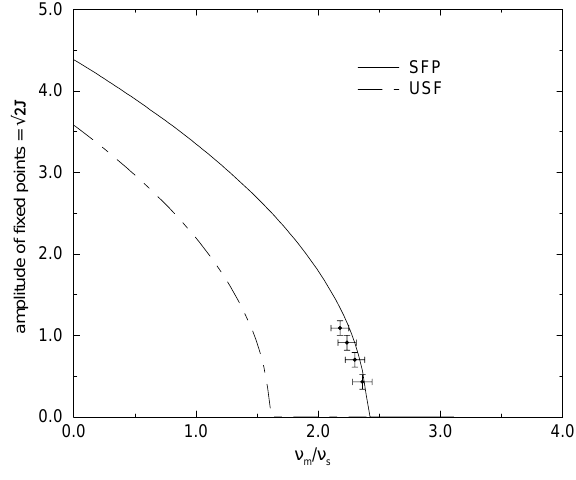
FIG. 7. Measured locations of stable fixed